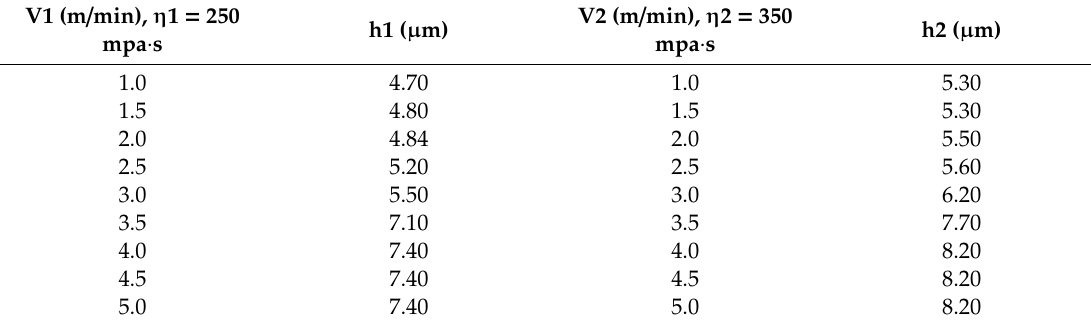
Table 1. Coating wall thickness with di ff erent speed and viscosity.